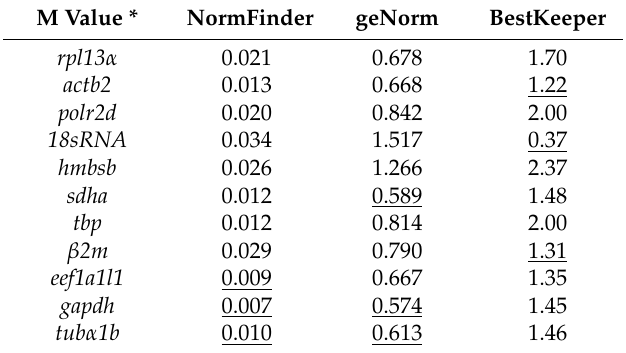
Table 2. Stability analysis of candidate reference genes in the zebrafish embryo mitoxantrone test before 48 hpf *.